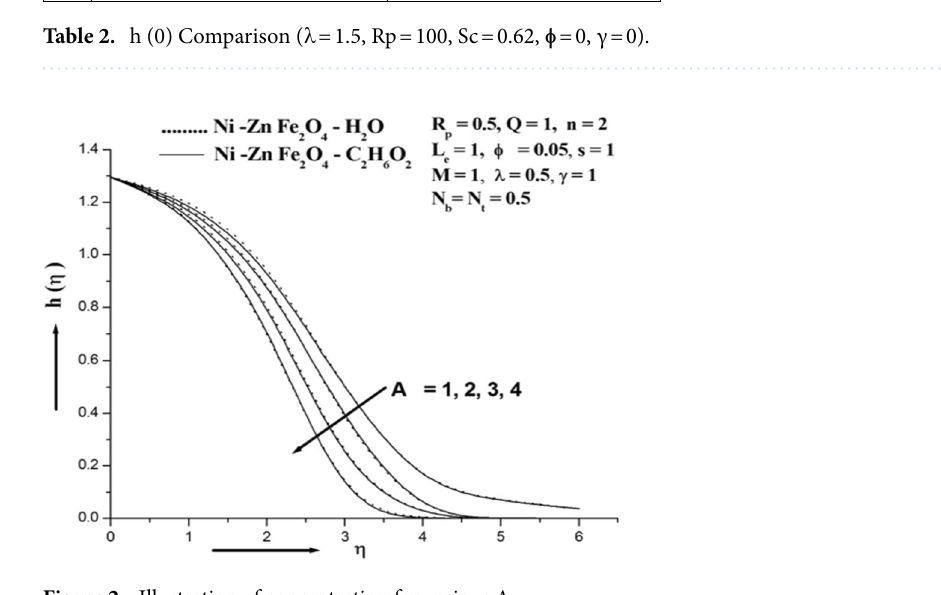
Figure 2. Illustration of concentration for various